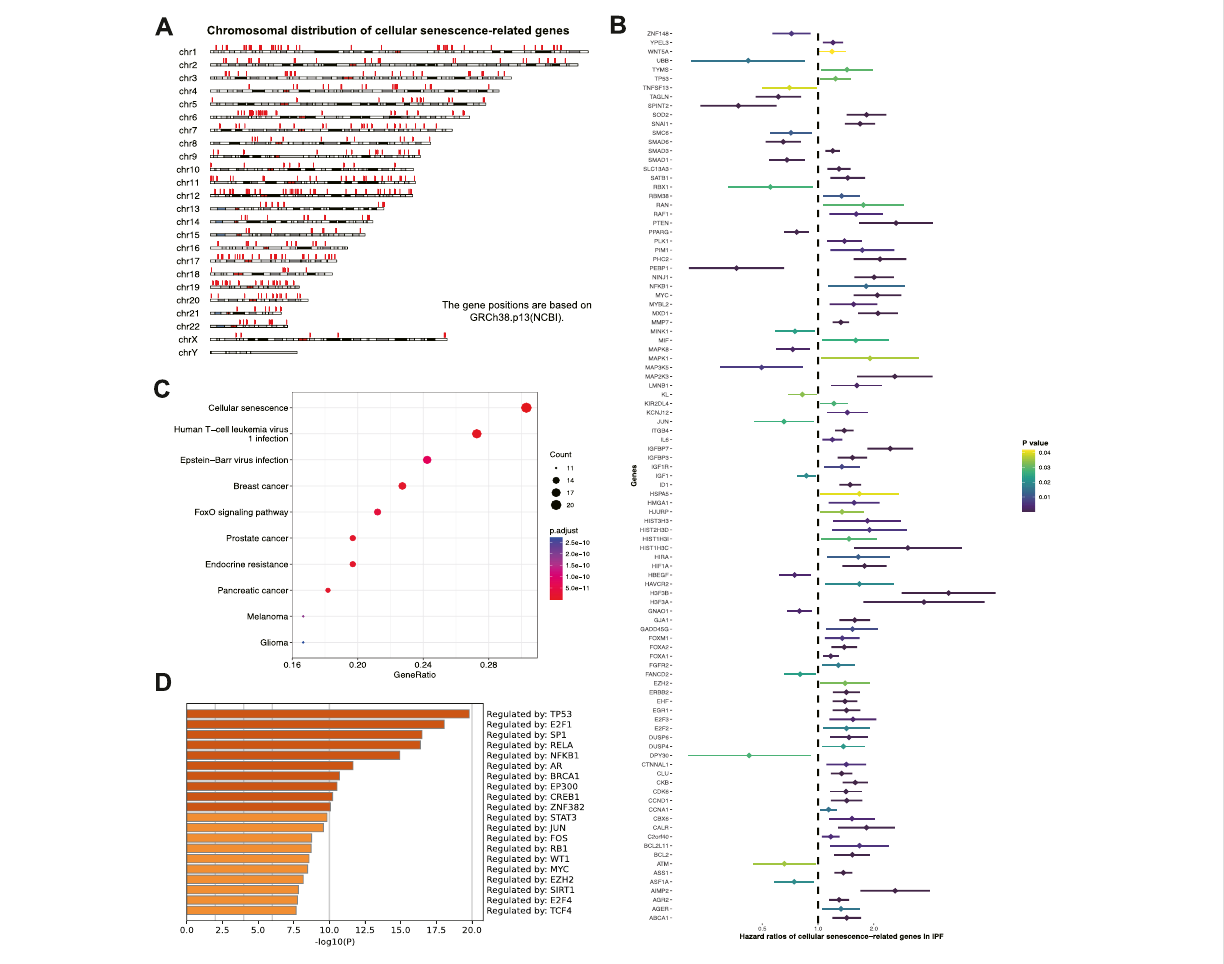
FIGURE 2 Screening prognostic cellular senescence-related genes in IPF. (A) Chromosomal distribution of cellular senescence-related genes in IPF. Each red line represents a gene. (B) Forest maps of single factor survival analysis of cellular senescence-related genes of IPF. (C) KEGG enrichment analysis of prognostic cellular senescence-related genes. Dot size corresponds to the count of genes in each pathway. (D) TRRUST enrichment analysis of prognostic cellular senescence-related genes.